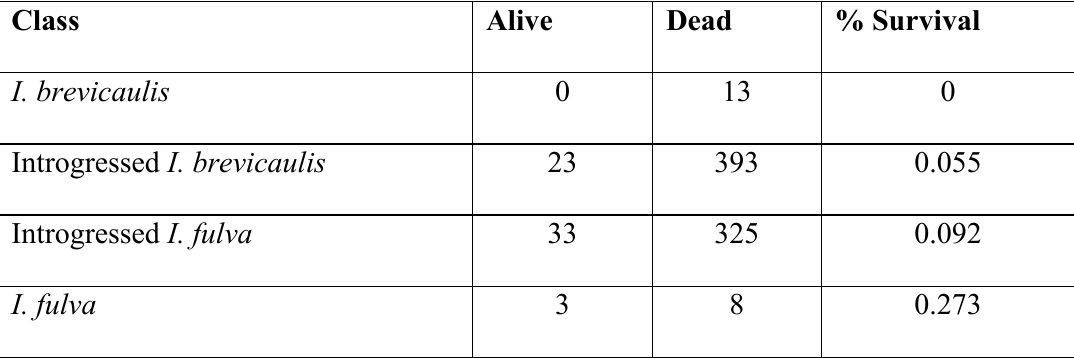
Table 2. Survivorship frequencies for I. brevicaulis , I. fulva and introgressed genotypes of these two species. Survivorship estimates were derived after a severe flooding episode [31].